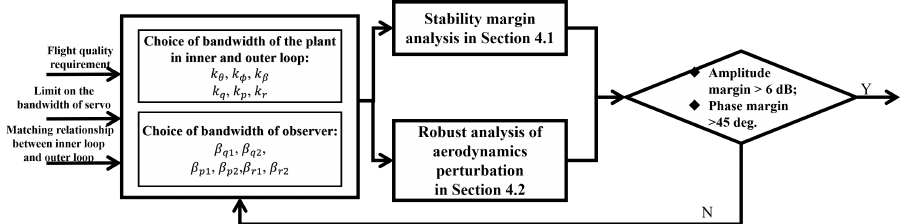
Figure 14. The flow of control law